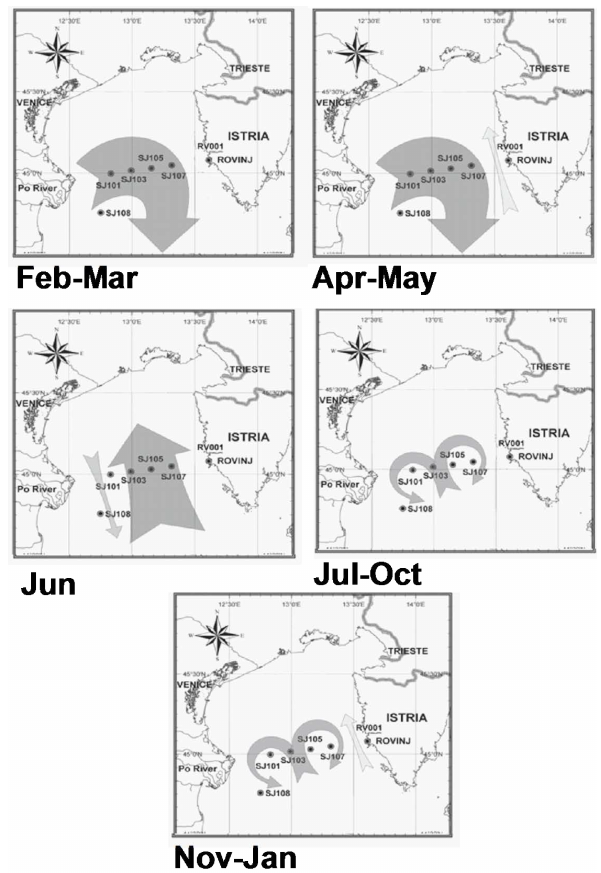
Figure 3. NA circulation patterns as hypothesised from average sur- face geostrophic currents relative to 30dbar in 1990–2004 between neighbouring stations at the Po River delta–Rovinj profile. Istrian Coastal Countercurrent (ICCC) at SJ107/RV001 directed towards SE.